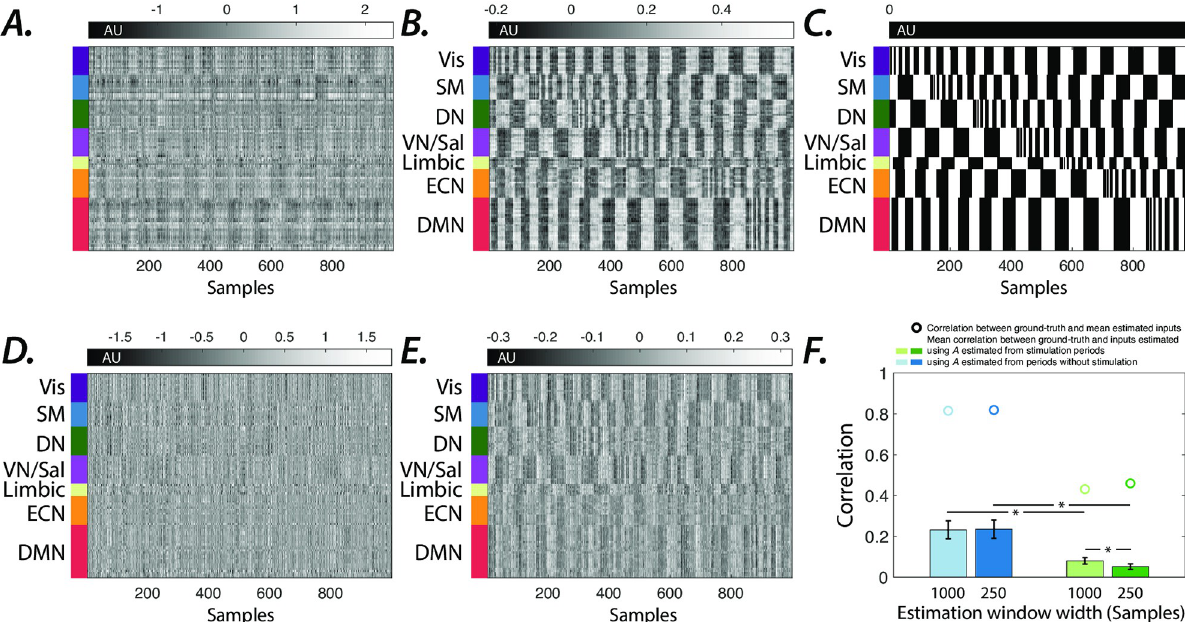
Fig 2. Extracting spatiotemporal profiles of unknown external drivers in simulated brain dynamics. ( A & D ) Estimated external inputs (i.e., B × U ) to all brain regions from synthetic time series generated from a sample subject’s internal system parameters and ( B & E ) the average estimated external inputs across all subjects (input matrix B dimension = 7, regularization factor = 0.5). Brain regions (y-axis) are sorted based on resting-state networks identified by [50], namely the visual (Vis), sensory/motor (SM), dorsal attention (DN), ventral attention/salience (VN/Sal), limbic, executive control (ECN), and default mode network (DMN). System parameters in panels D & E are estimated from the stimulation window, however system parameters in panels A & B are estimated from same-length windows without external inputs. (C) Ground-truth synthetic inputs over 1000 samples (TR = 0.72 sec). (F) The similarity between ground-truth and estimated inputs. The system matrix A estimated from windows without external stimulation results in a significantly higher correlation between the vectorized estimated external and ground-truth input matrices ( t − test, p < 0.05, p = 6.6 × 10 − 65 and p = 2.9 × 10 − 66 for estimation windows with 1000 and 250 samples, respectively), compared to system matrix A estimated from the stimulation windows (indicated by ‘ � ’ markers). The smaller estimation windows significantly ( t − test, p < 0.05, p = 1.15 × 10 − 45 ) reduce the estimated and ground-truth inputs’ similarity, only for the system matrix A estimated over stimulation windows (indicated by ‘ � ’ markers). The correlation values between the ground-truth and group average estimated inputs are indicated by ‘o’